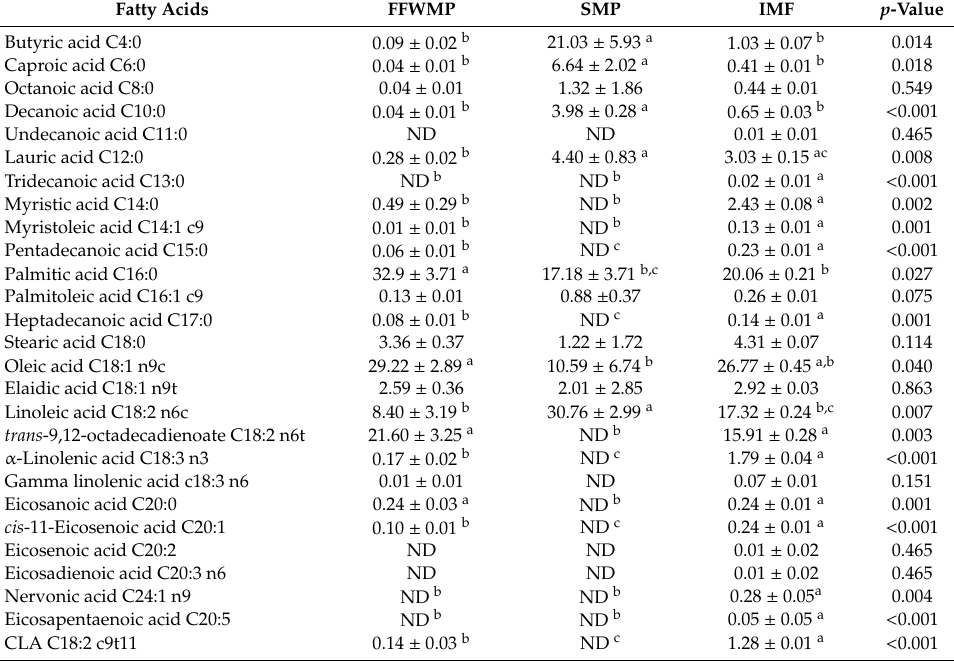
Table 1. Fatty acid (FA) composition (g / 100 g of FA ± SD; n = 3) of fat-filled whole milk powder (FFWMP), skim milk powder (SMP), and infant milk formula (IMF). Di ff erent superscripts within a row indicate significant di ff erences between the samples ( p = 0.05).